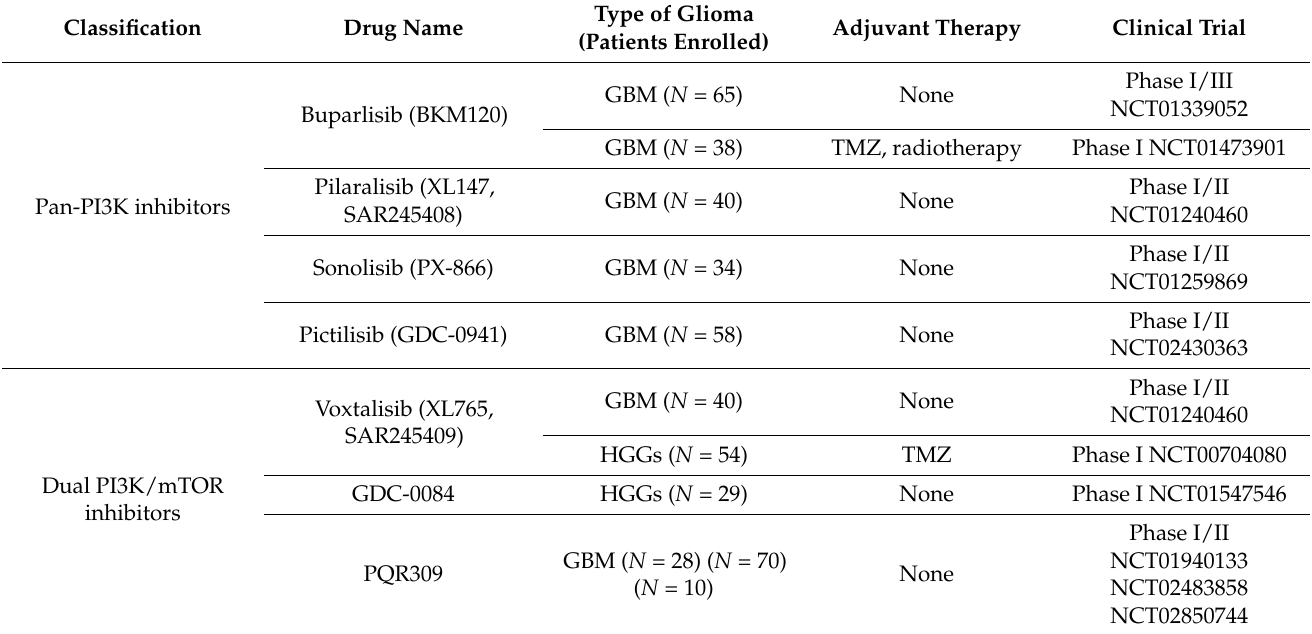
Table 3. Ongoing clinical trials on adult gliomas targeting PI3K (data from http://clinicaltrials.gov, accessed on 30 April 2021).